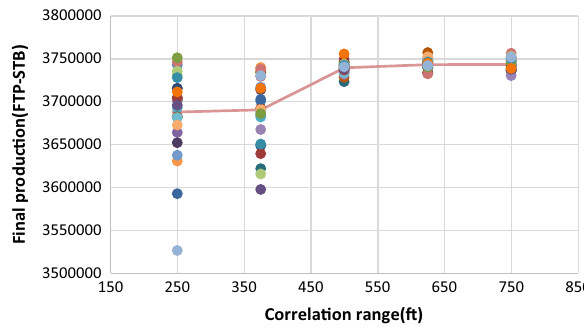
Fig. 5 Final production of reservoir versus correlation range